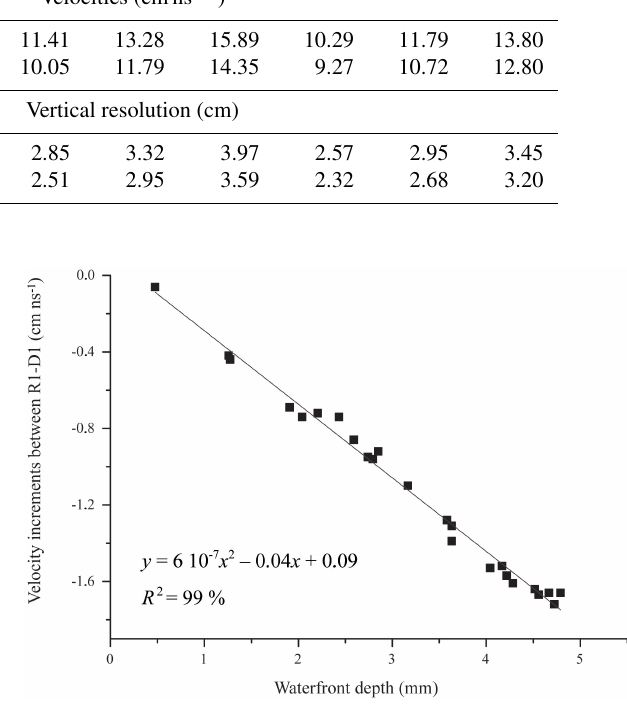
Table 2. Theoretical vertical resolution, considering the different peaks combinations to calculate velocities. Peaks considered to calculate velocities R1–D1